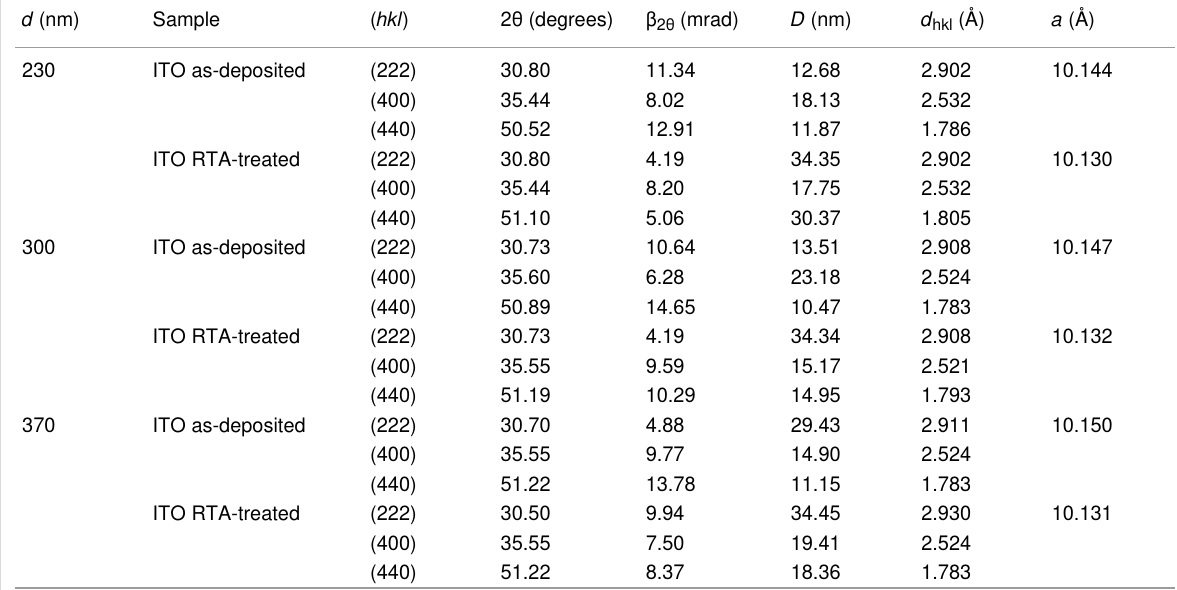
Table 2: XRD results for as-deposited and RTA-treated ITO thin films, with different thickness values. a